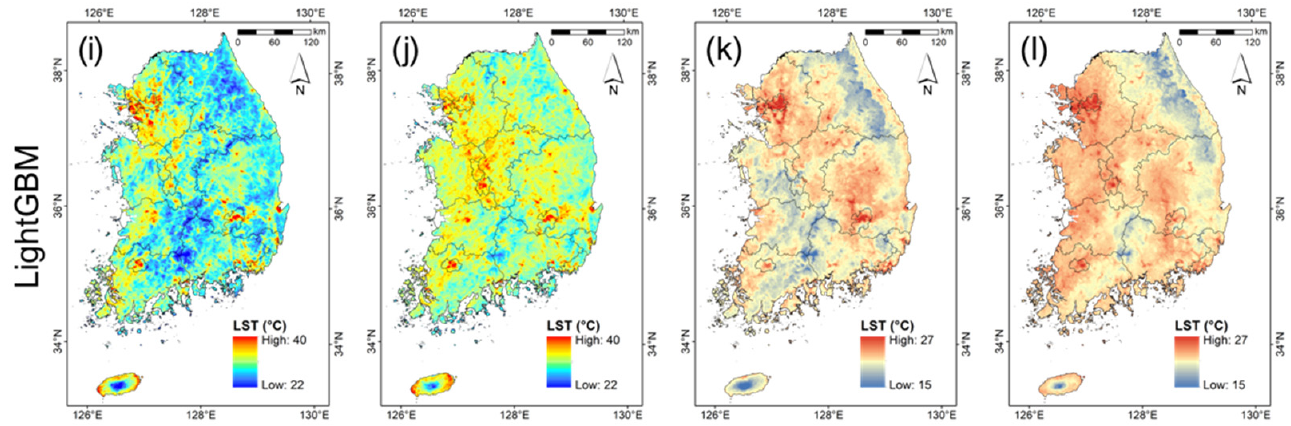
Figure 9. Spatial distribution of 1 km LSTs from ( a - d ) MODIS, ( e - h ) LDAPS, and ( i - l ) LightGBM for